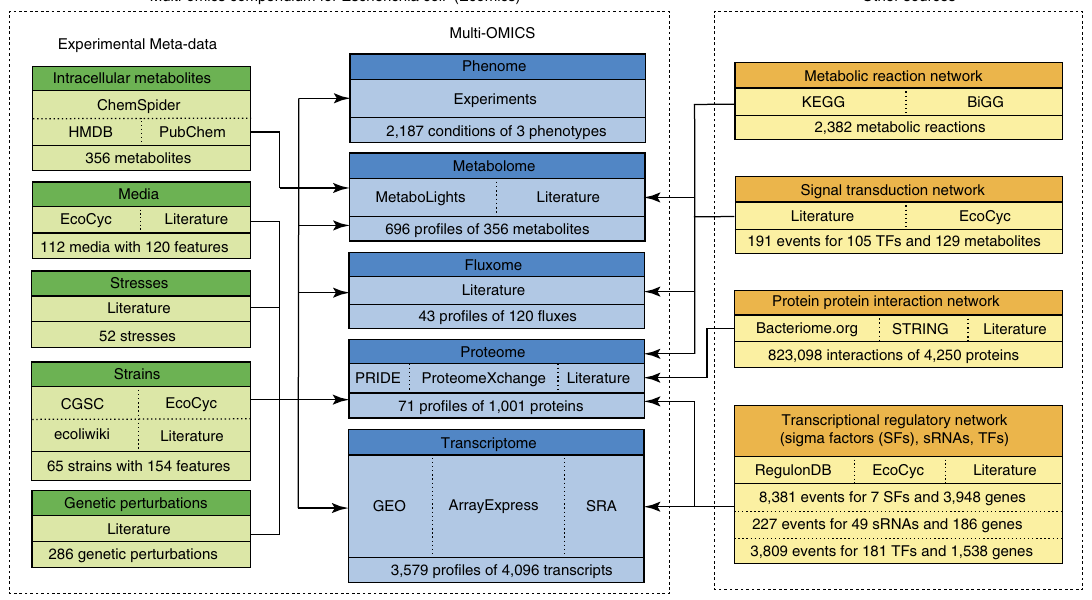
Figure 1 | Overview of the Ecomics data sources. The Ecomics compendium is divided into two major parts, the multi-omics genome-scale profiles and the experiment meta-data. In addition to the Ecomics compendium, we have curated genome-scale interaction data for signal transduction, transcriptional, protein and metabolic